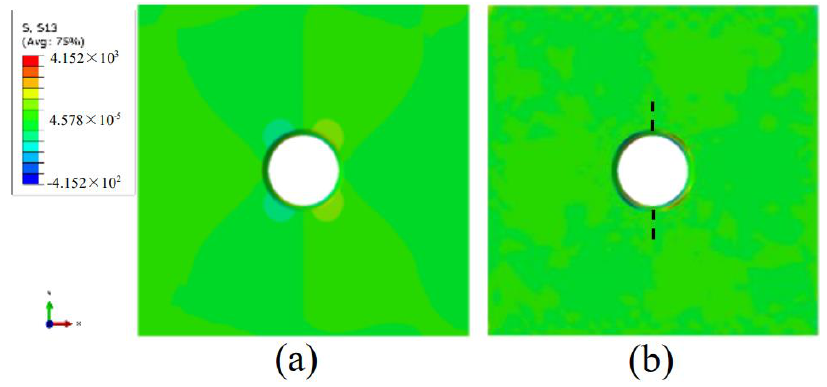
Figure 19. Torsional shear distribution. ( a ) Model 1; ( b ) Model 2.